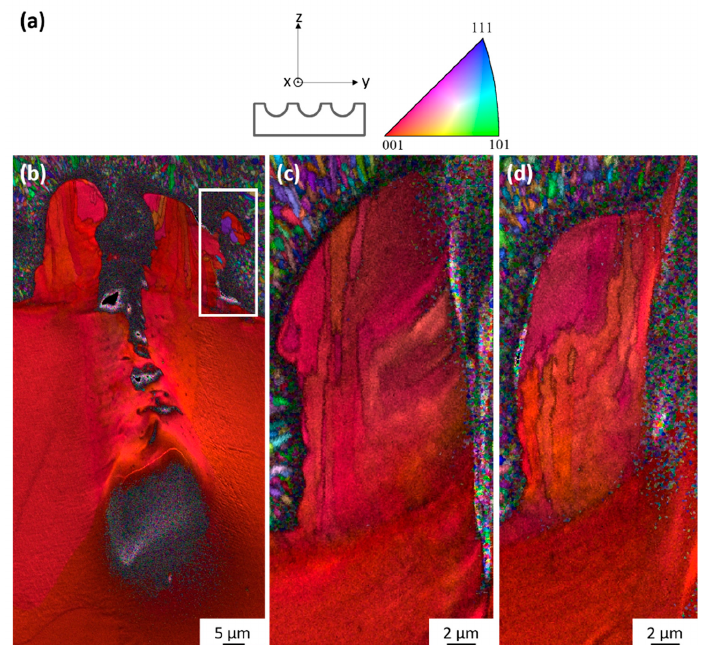
Figure 7. Crystallographic orientation mapping, coded along the z-axis of pattern 1: ( a ) reference frame and inverse pole figure ( b ) mapping of the entire pattern 1, ( c , d ) zoom on two different asperities. The textured surface of the AM1 was previously nickel.